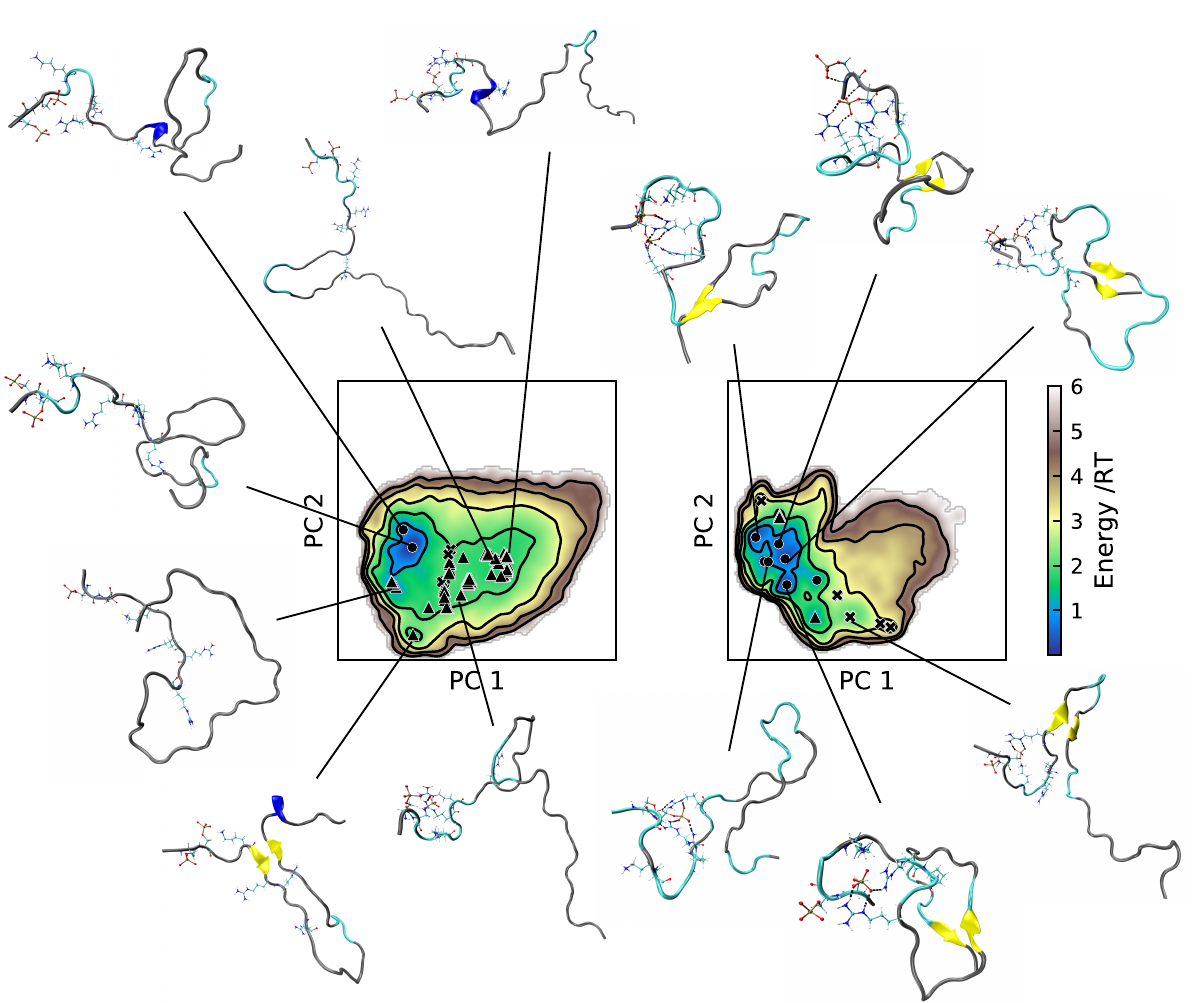
Figure 8. Energy landscapes and conformations in selected minima of Stath. ( Left ) A99; ( right ) C36. The energy landscapes are constructed using the first two components from principal component analysis, using the same basis set for both force fields, such that they are directly comparable. Contour lines are drawn for integer energy levels in the interval 1 ≤ RT ≤ 5, and the minimum of each basin is represented by a marker: (cid:108) : energy ≤ 1RT, (cid:115) : ≤ 2RT, (cid:54) : ≤ 3RT. In the conformations, the phosphorylated and positively charged residues are shown explicitly. Dashed black lines represent hydrogen bonds. The peptide conformations are color-coded according to the secondary structure determination in VMD, where silver is irregular (coil), cyan is turns, blue is the 3 10 -helix, yellow is the β -sheet, and tan is the β -bridge. The N-terminus of each conformation is the leftmost/topmost